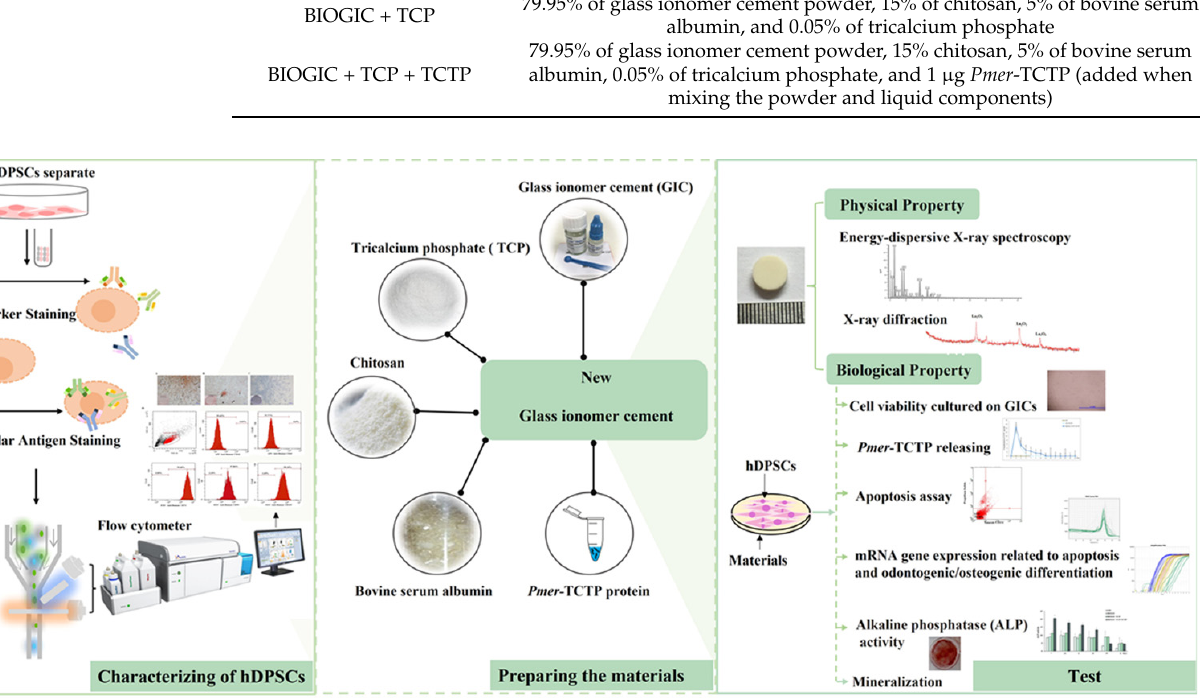
Figure 2. Overview schematic illustration of the physical and biological